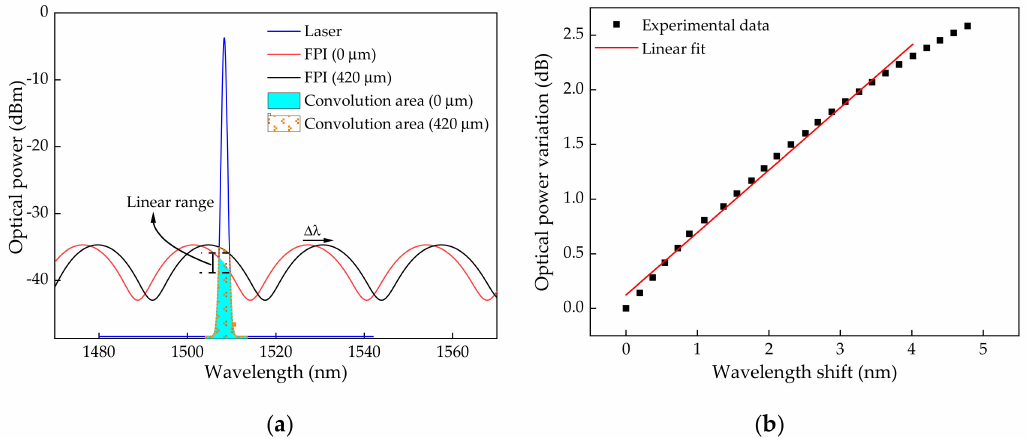
Figure 7. ( a ) Illustration of the proposed interrogation architecture limits; ( b ) Relationship between the FPI modulated transfer function wavelength shift and reflected optical power due to the laser and interference function